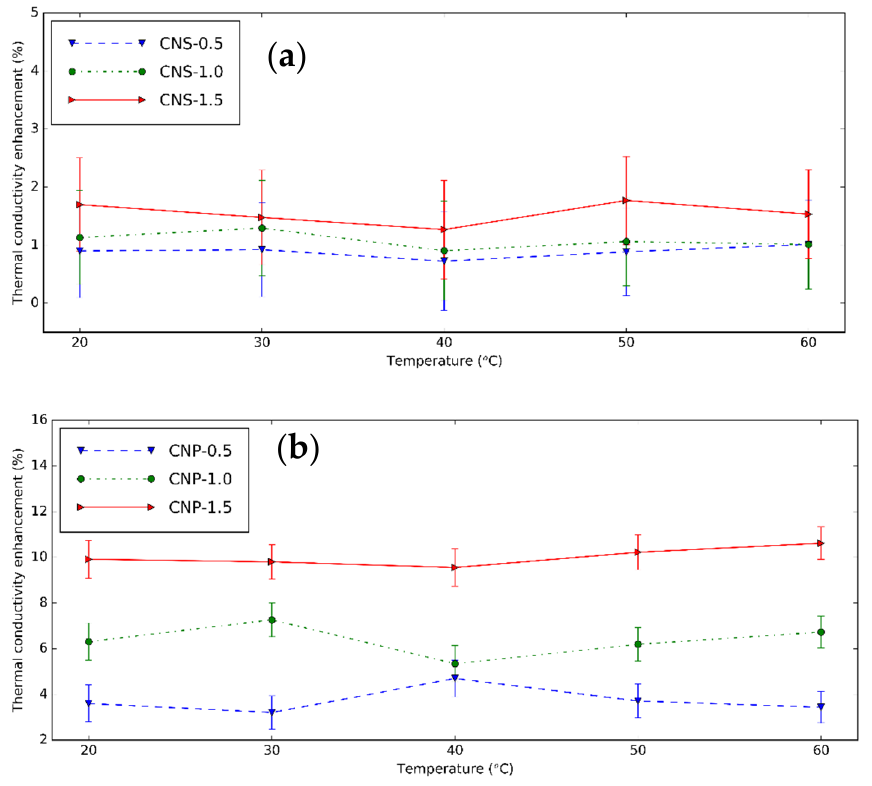
Figure 12. k enhancement of ( a ) CNS and ( b ) CNP nanofluids with different concentrations at different temperatures.